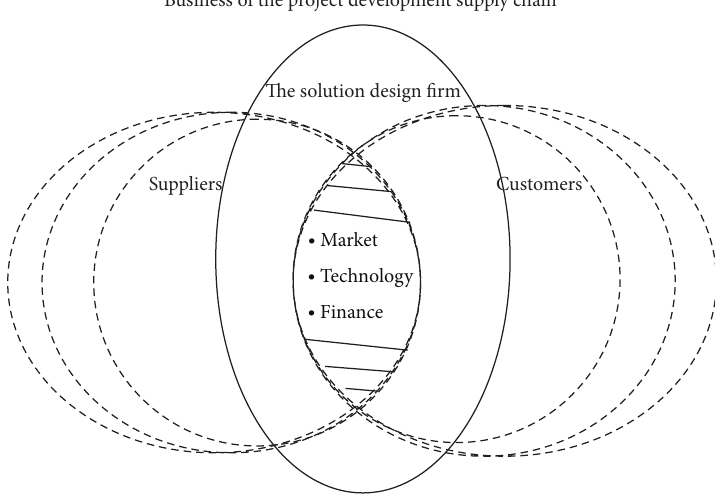
Figure 2: Business of the project development supply